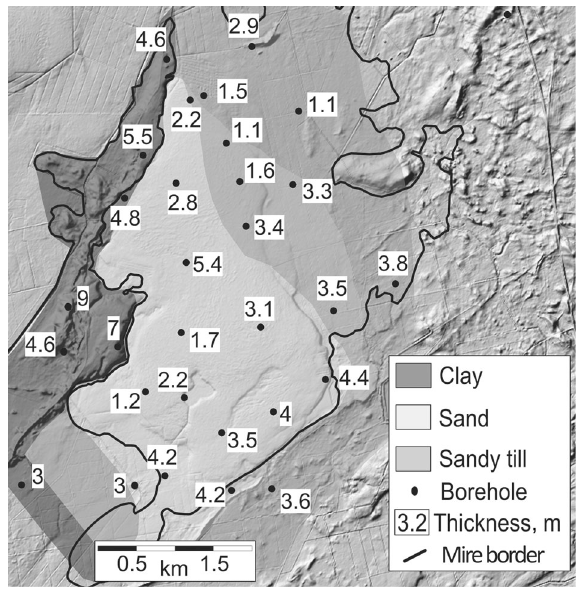
Fig. 7. Thickness and lithology of the Quaternary sediments below the Selisoo mire. Sand and till layers are overlapping in the NW side of the mire area.